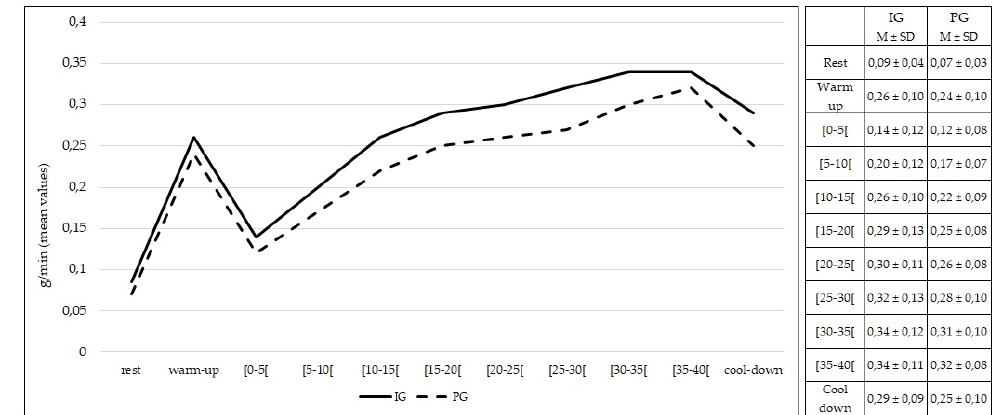
Figure 4. Lipid oxidation during rest, exercise, and cool-down in intervention group and placebo group. Data are expressed as mean ± standard deviation. IG: intervention group; PG: placebo group.